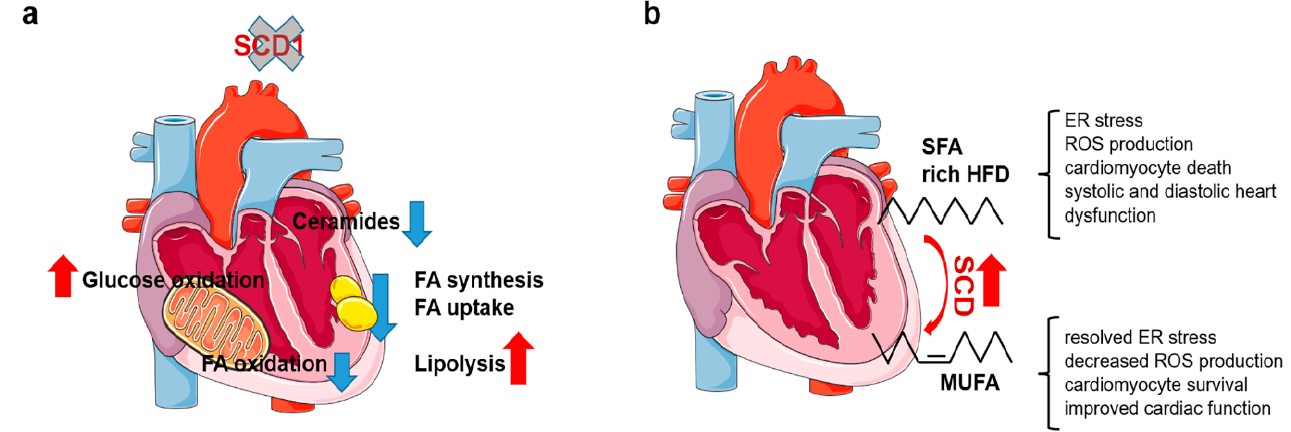
Figure 1. Role of SCD in the regulation of cardiac physiology and metabolism. ( a ) SCD1 deficiency stimulates a switch in substrate utilization in the heart from FA β -oxidation to glucose oxidation. Such a change may be involved in the improvement in heart function in obese leptin-deficient ob/ob mice. Additionally, SCD1 deficiency reduces de novo FA synthesis and uptake, thereby reducing the synthesis of toxic ceramides. The loss of SCD1 also reduces cardiac steatosis in PPAR α -deficient mice by stimulating ATGL and HSL. ( b ) An increase in SCD activity in the heart protects against metabolic changes that are induced by a HFD with high SFA content. SCD detoxifies SFA excretions, producing MUFA. This leads to the elimination of ER stress and promotes cardiomyocyte survival, resulting in an improvement in cardiac function. The red arrow indicates the activation of the process. The blue arrow indicates the decrease of the process/decline of the content of a given factor.